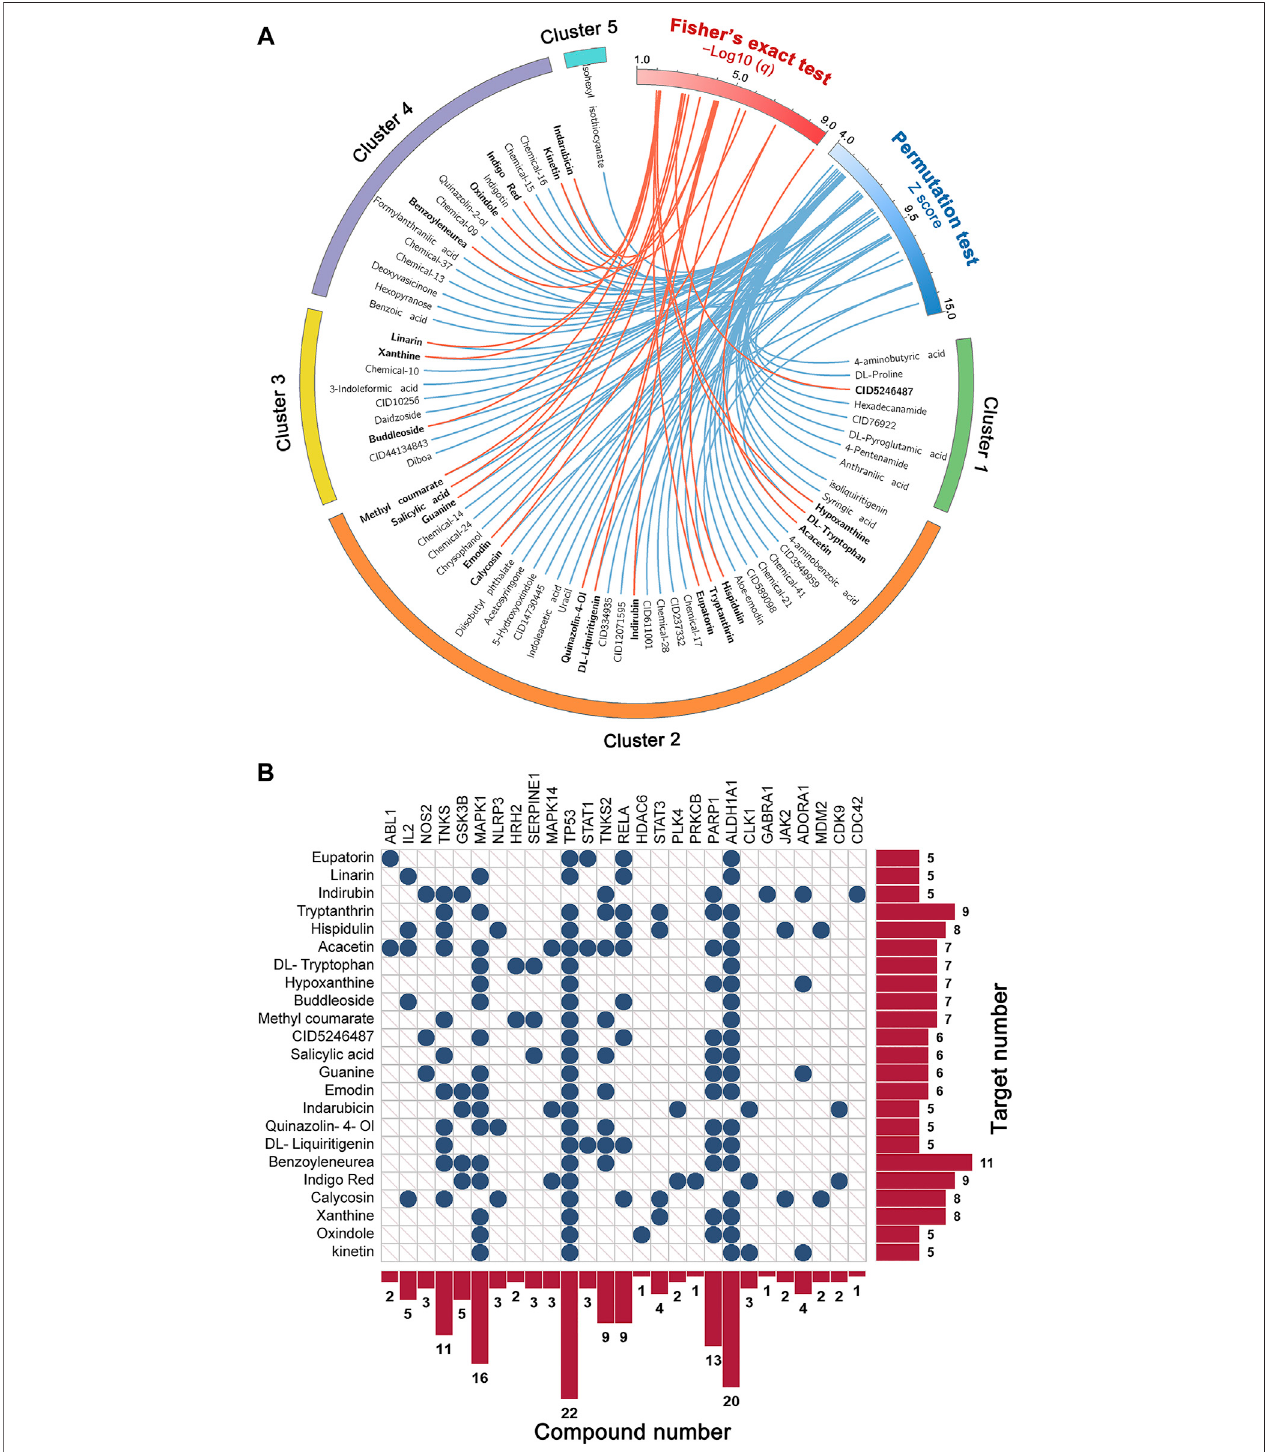
FIGURE4| Identi fi cation ofthepotentialanti-in fl uenza A virus(IAV) candidates in Isatistinctoria L. (BLG) using statistical network models. (A) Circos plotexhibiting the71predictedpositivecompounds( q < 0.05)bymodelsbasedonpermutationtest(modelA)andFisher ’ sexacttest(modelB).Compoundssimultaneouslypredicted aspositivebythetwomodelsarehighlightedin boldfont . (B) Targetdistributionofthe23compoundsthatweresimultaneouslyidenti fi edaspotentialanti-IAVcandidates by the two models.